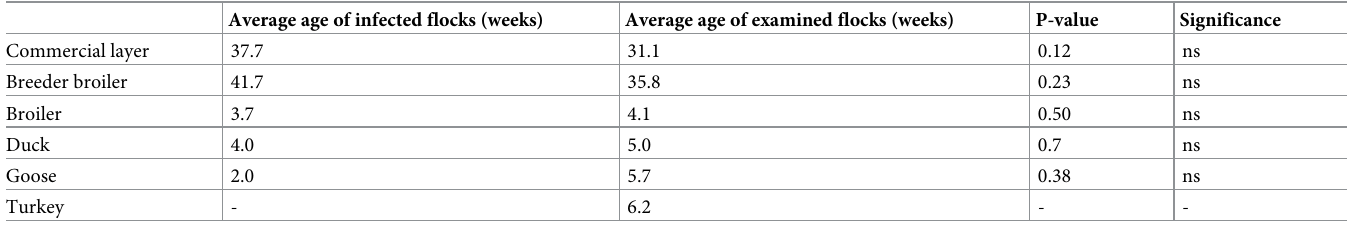
Table 2. Average age of infected flocks versus average age of examined flocks. Average age of infected flocks